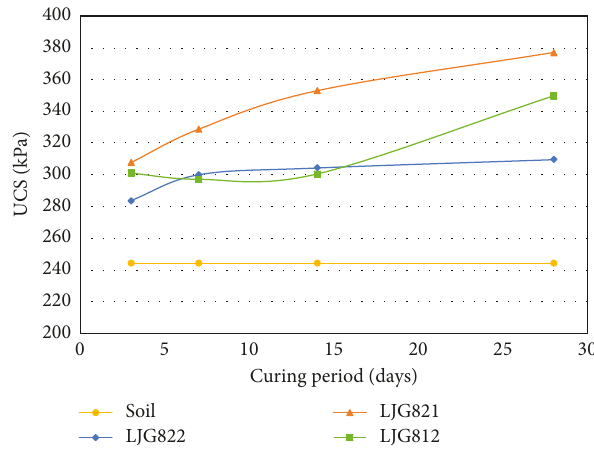
Figure 3: UCS of LJG combinations with